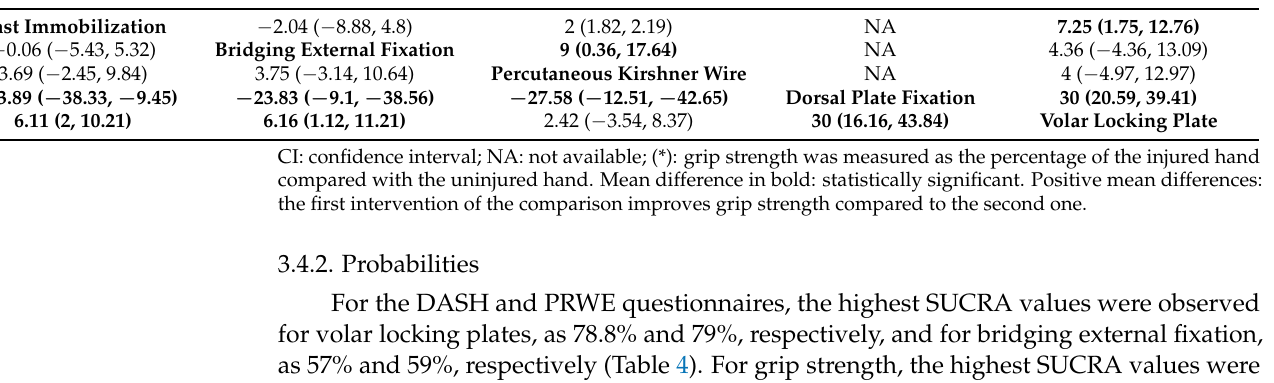
Table 3. Absolute and relative mean difference estimates (95% CI) on grip strength (*). Upper right triangle gives the mean difference from pairwise comparisons (column intervention relative to row) and lower left triangle gives the mean difference from the network meta-analysis (row intervention relative to